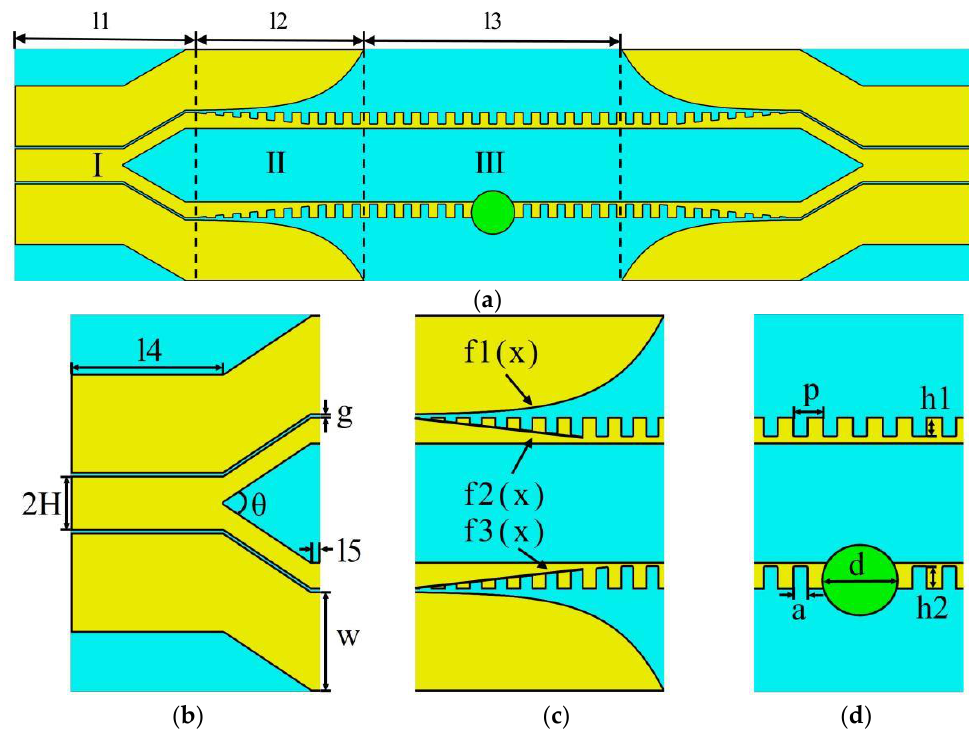
Figure 1. ( a ) Schematic of the SSPP waveguide structure, where l1 = 52.5 mm, l2 = 50 mm, l3 = 75 mm; ( b ) Coplanar waveguide; ( c ) Matching transition structure; ( d ) SSPP transmission lines and measured sample.